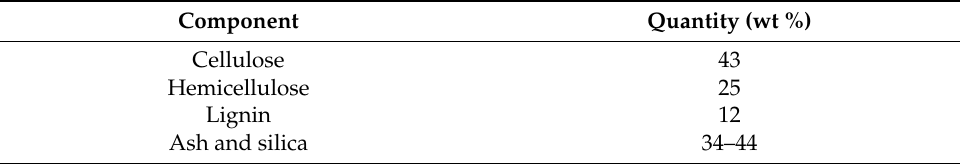
Table 1. Composition of rice straw